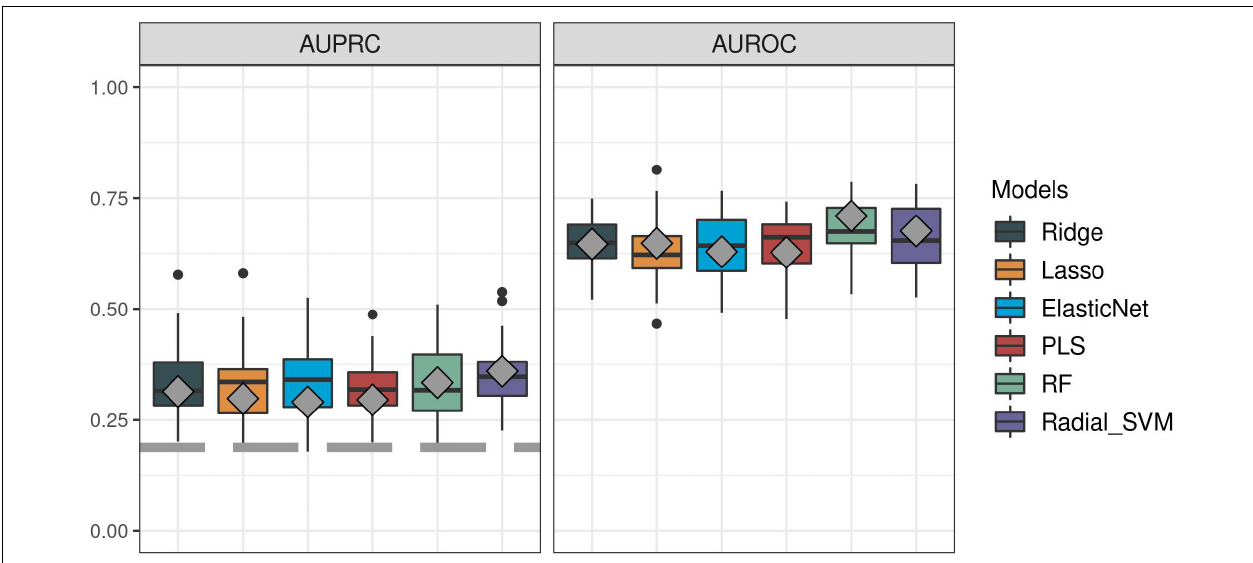
FIGURE 2 | Predictive performance of the IPP gene set on “day 1” discovery and validation sets. We trained machine learning models on the “day 1” discovery ( n = 1,007) and validation ( n = 430) data sets by 5 repeats of 10-fold cross-validation, and computed areas under the receiver operating characteristic (AUROC, right panel) and precision-recall curves (AUPRC, left panel) on the resampled discovery set (box plots) and by prediction on the validation set (gray diamonds). Gray dashed line on the AUPRC facet indicates baseline probability of the outcome (death).